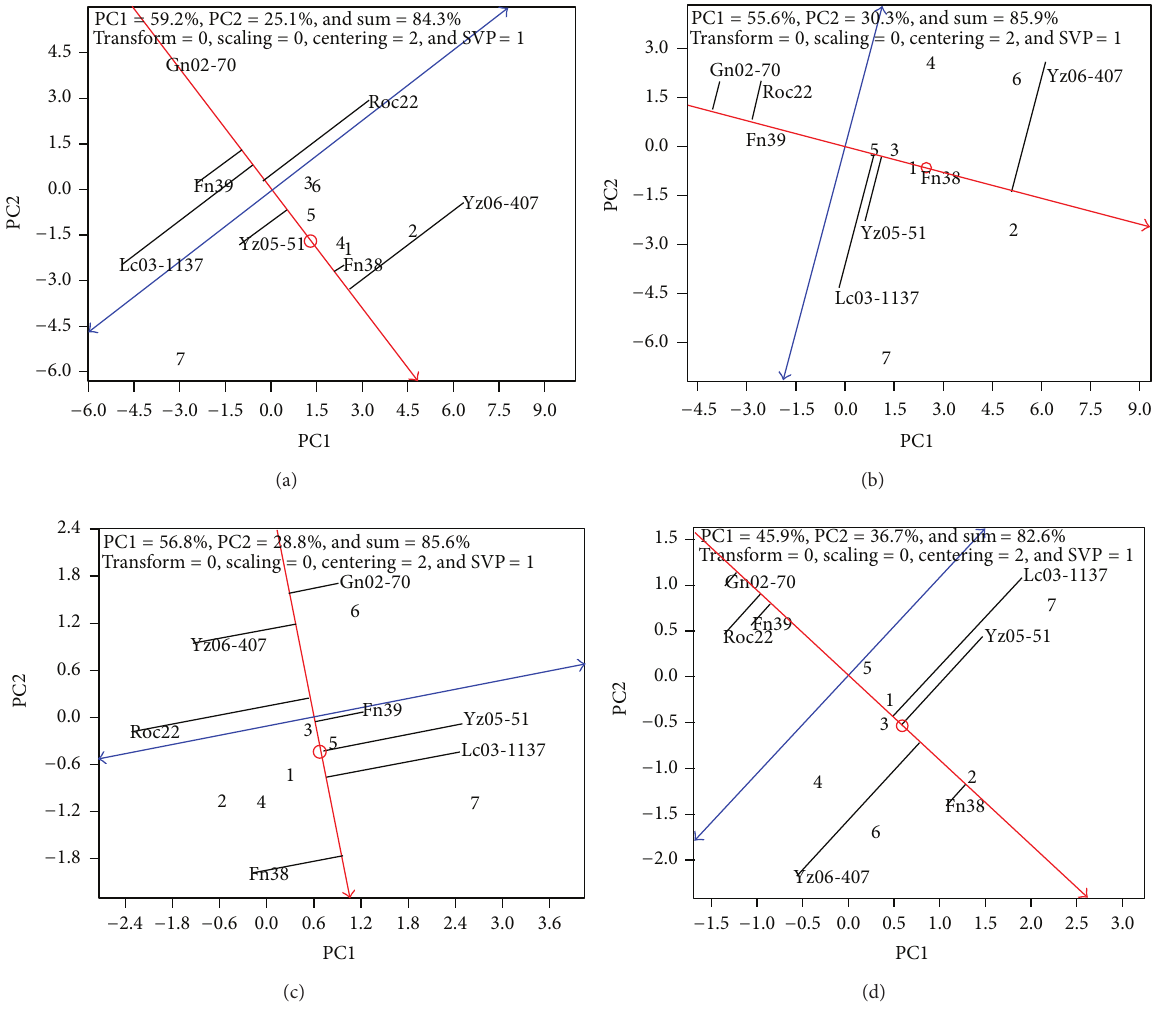
Figure 2: Stability of cane and sugar yields based on GGE-Biplot analysis. The circle represents the average environment. The single arrow red line is average environment-axis, projecting each cultivar’s average yield from all evaluation sites. Through the original point and perpendicular to the red line, the double arrow blue line measures the vector stability between cultivar and environment. The closer to the average environment-axis, the more stable the cultivar’s performance. Refer to Figure 1 legend for Panel, PC1, PC2, numerical codes for evaluation sites, and codes for